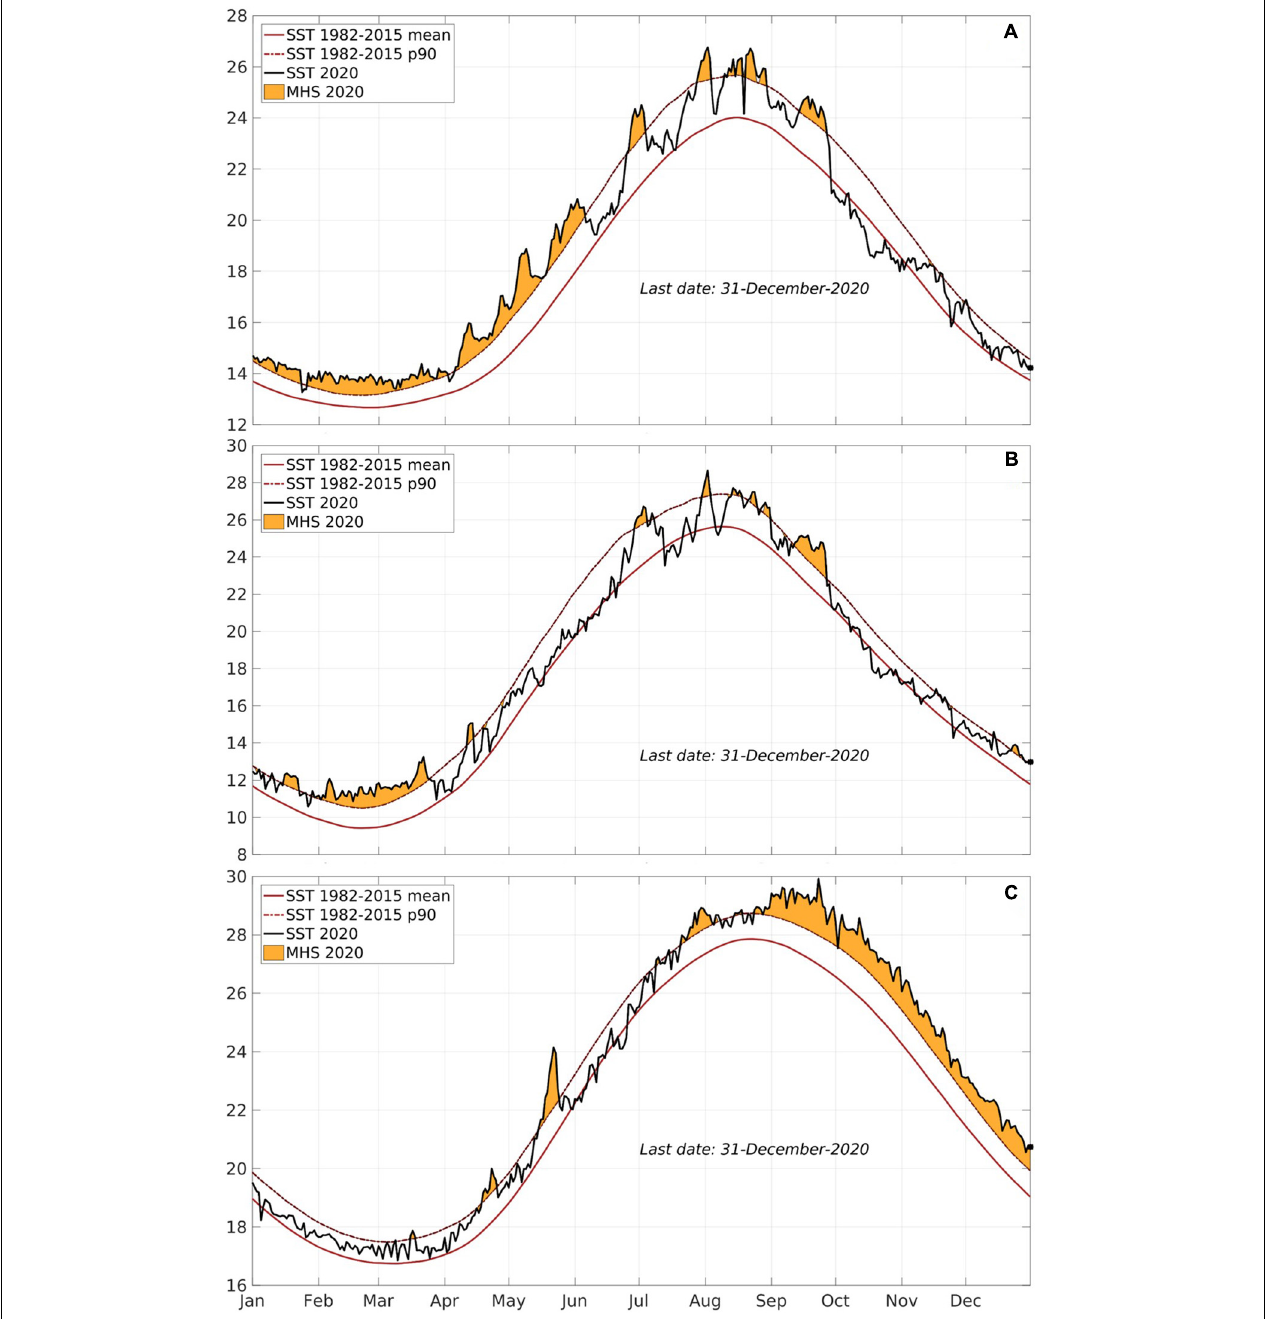
FIGURE 4 | Sub-regionally integrated time series of daily SST with MHS highlighted in the Gulf of Lion [DF2] (A) , North Adriatic [DJ1] (B) , and Levantine South-East basin [DL4] (C) as observed in 2020, and of daily mean and 90th percentile